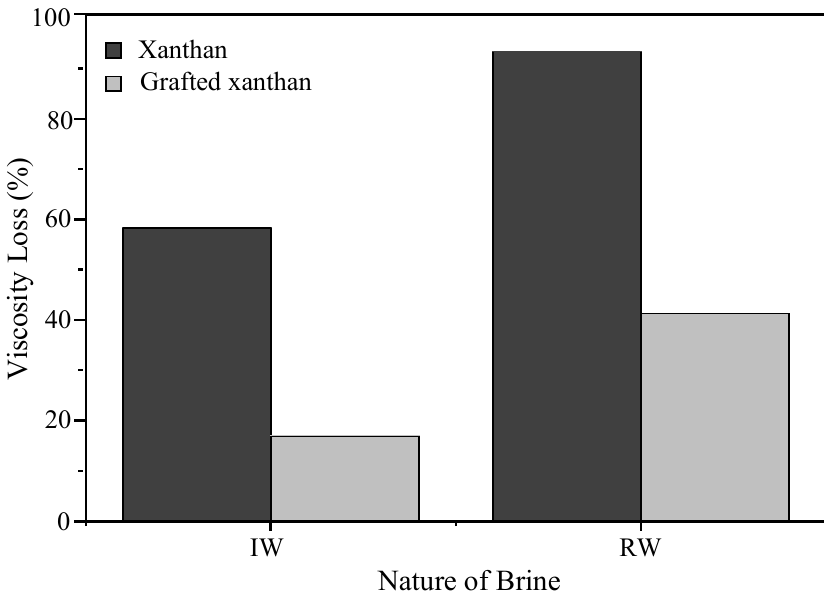
Figure 4. Viscosity loss ratio of polymer-brine solutions.